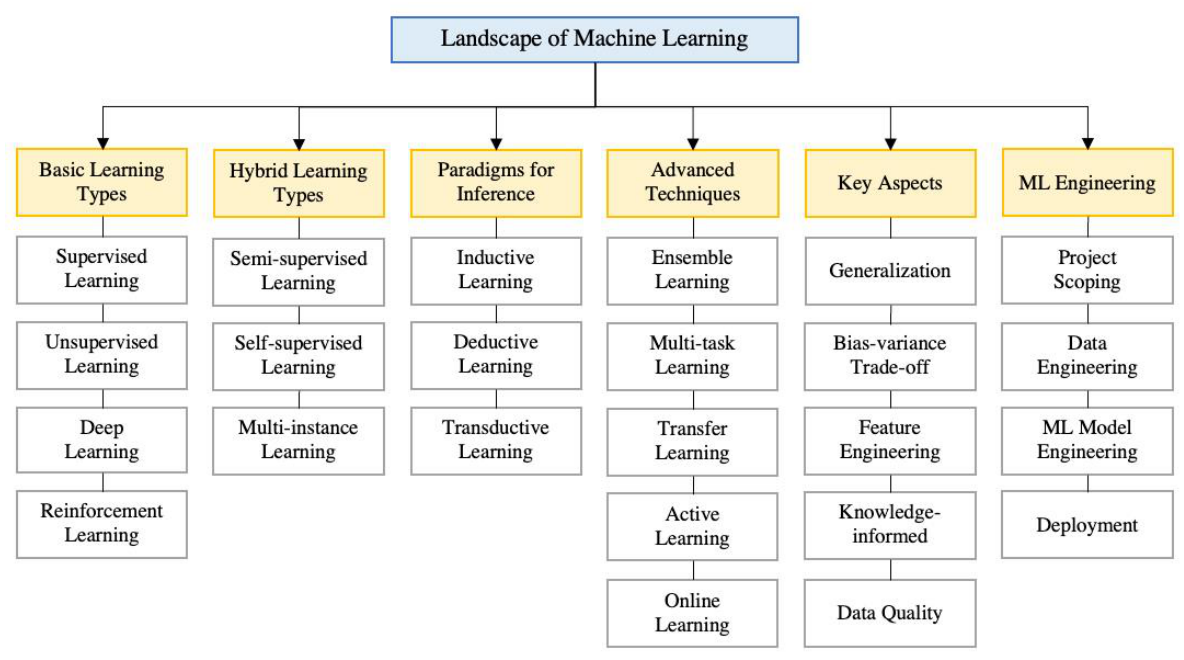
Figure 2. Taxonomy of the landscape of machine